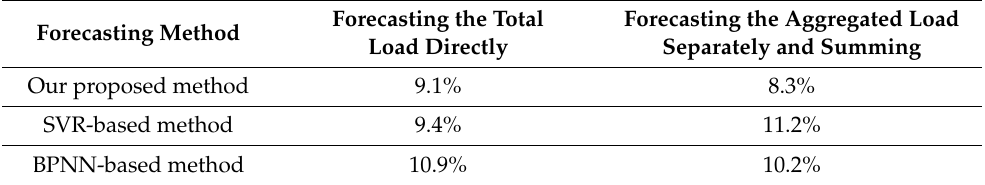
Table 9. The MAPE values of load forecasting results by our proposed method and traditional